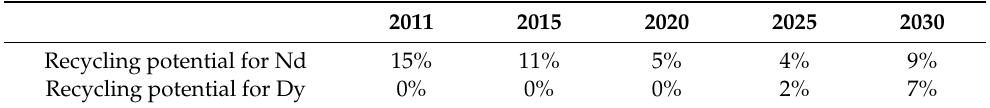
Table 4. Global recycling potentials for neodymium and dysprosium including wind, automotive, and HDD magnets